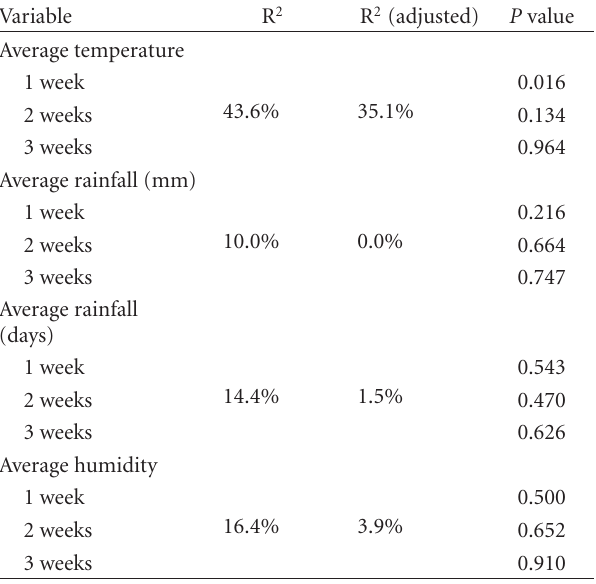
Table 3: Multiple-regression analysis among climate variables and sand flies yield from sampling of adults.